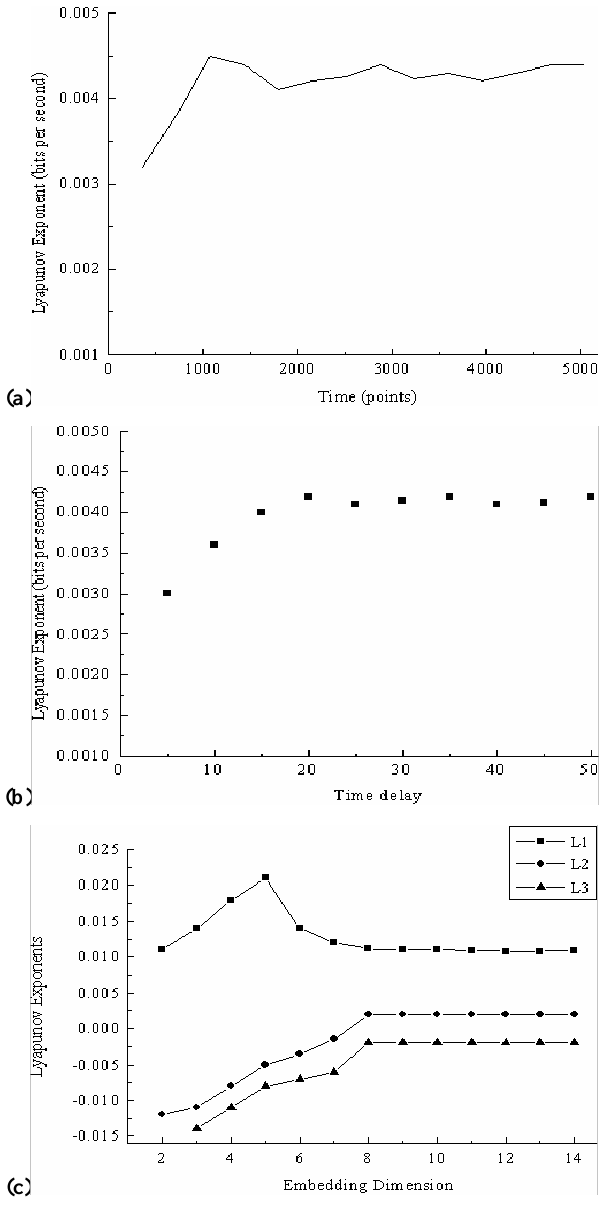
Fig. 3. Plots of (a) Lyapunov exponent computed and its evolution, as the state space trajectory scanned with τ = 20, m = 8 for the detrended TEC time series measured at Agatti, (b) Lyapunov exponent versus time delay, by keeping embedding dimension a constant, and (c) the spectrum of the first three Lyapunov exponents estimated for the detrended TEC time series measured at Agatti, as a function of the embedding dimension m